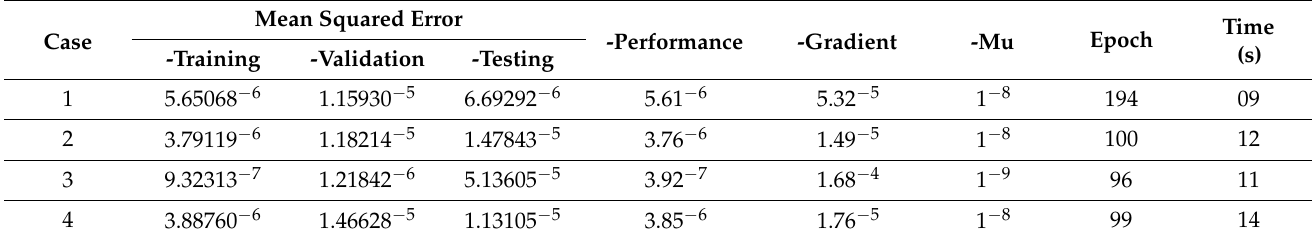
Table 3. Performance analysis of LMM-NNs for the proposed model.